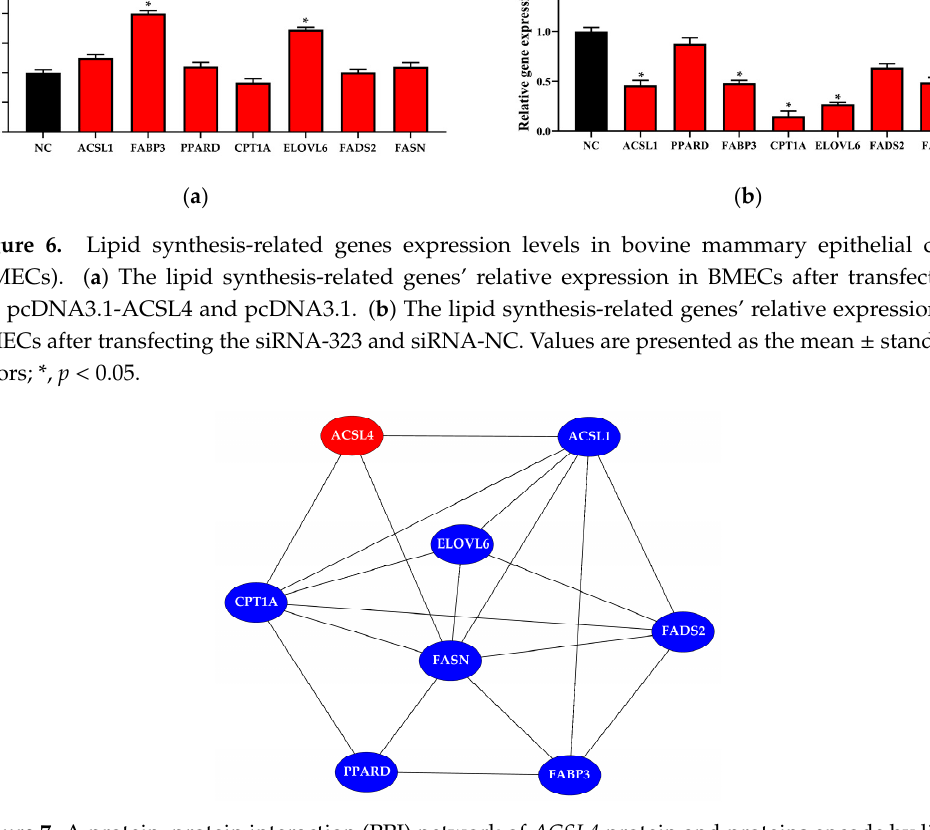
Figure 7. A protein–protein interaction (PPI) network of ACSL4 protein and proteins encode by lipid metabolism-related genes whose mRNA expression was detected.